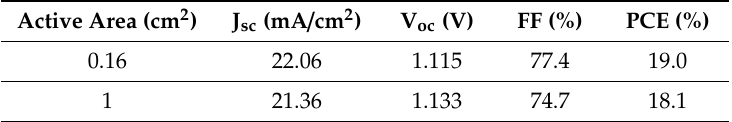
Table 5. PSCs’ photovoltaic parameters of the treated-MAPbI 3 PSCs with di ff erent active areas. The J sc , V oc , FF, and PCE values were measured in backward scanning mode.